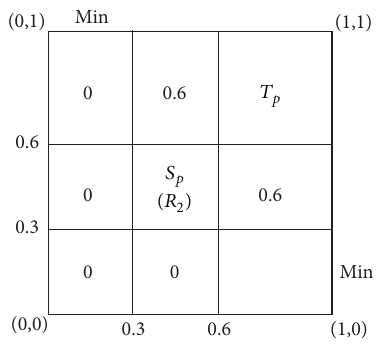
Figure 2: Graphical representation of 𝑅 9 (or 𝑅 10